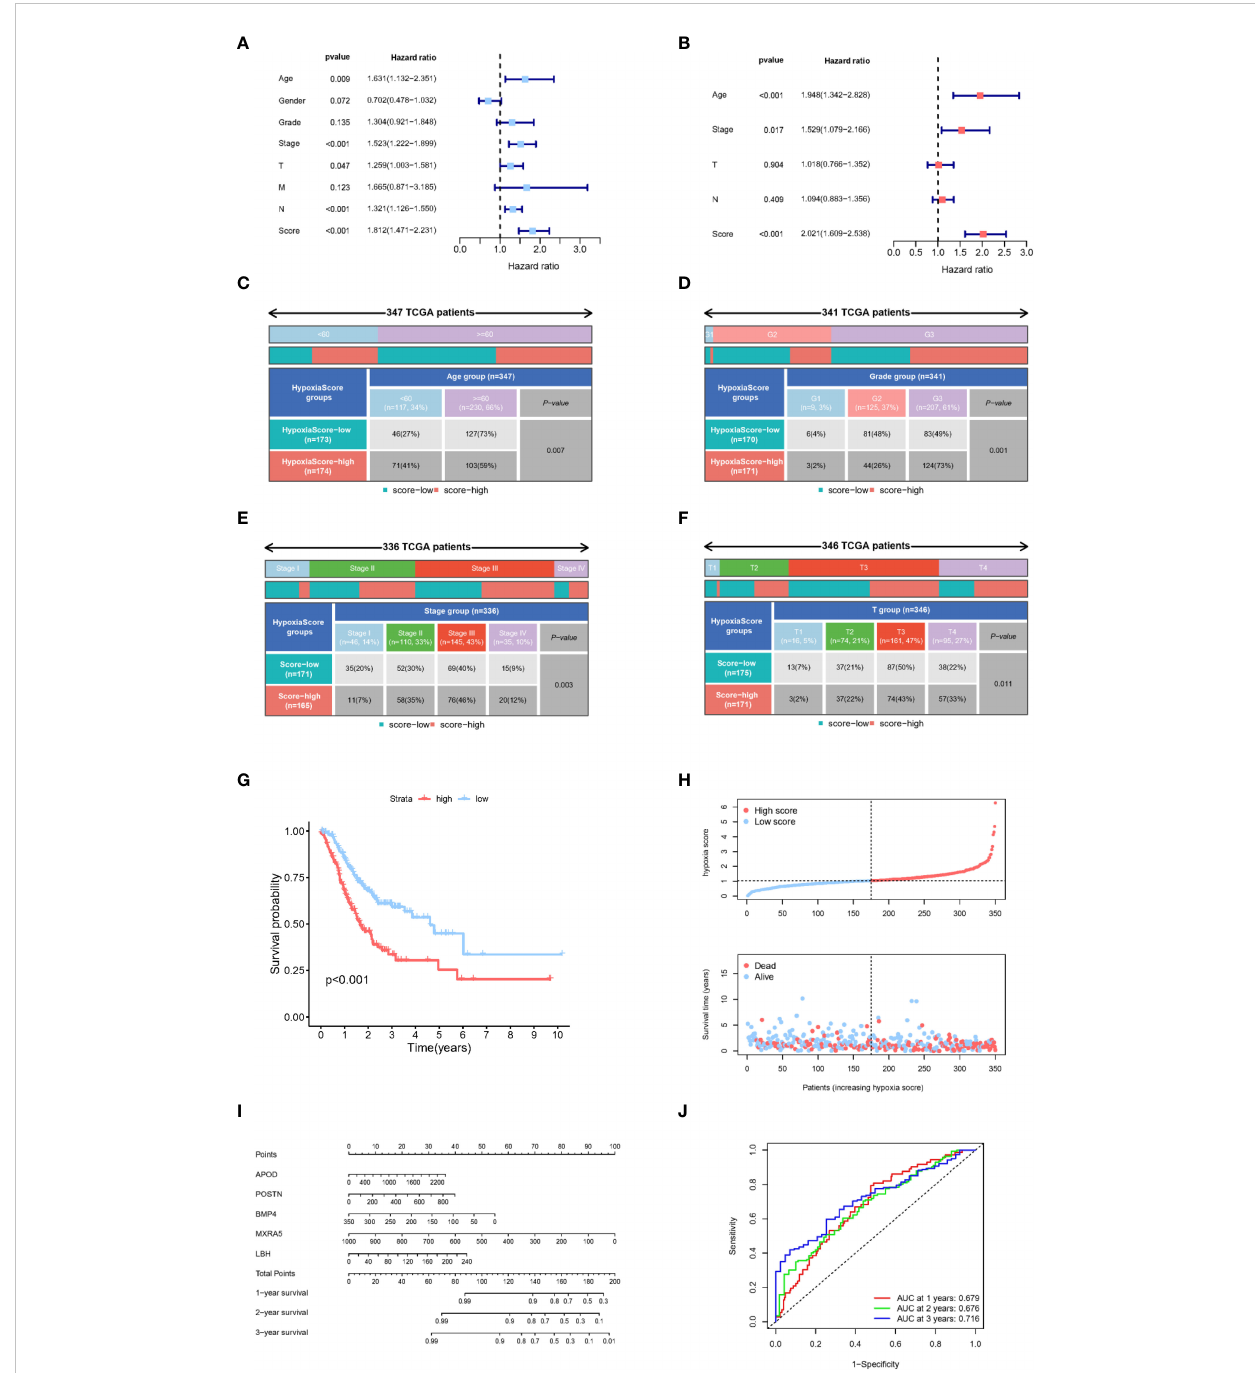
FIGURE 5 Clinical characteristics of the hypoxia-related gene model. (A) Univariate Cox regression analysis of clinical characteristics and hypoxia scores. (B) Multivariate Cox regression analysis of signi fi cant clinical characteristics and hypoxia scores. (C – F) . Age, grade, tumour stage and T stage were signi fi cantly different between the two hypoxia score subgroups. (G) Kaplan − Meier analysis of patients in different hypoxia score groups. (H) Relationship between survival status and hypoxia score in TCGA-GC patients. (I) The nomogram constructed with 5 hypoxia-related genes to predict the 1-, 3-, and 5-year OS in GC patients in the TCGA cohort. (J) ROC curves of key hypoxia genes for predicting 1-, 3-, and 5-year OS in the TCGA